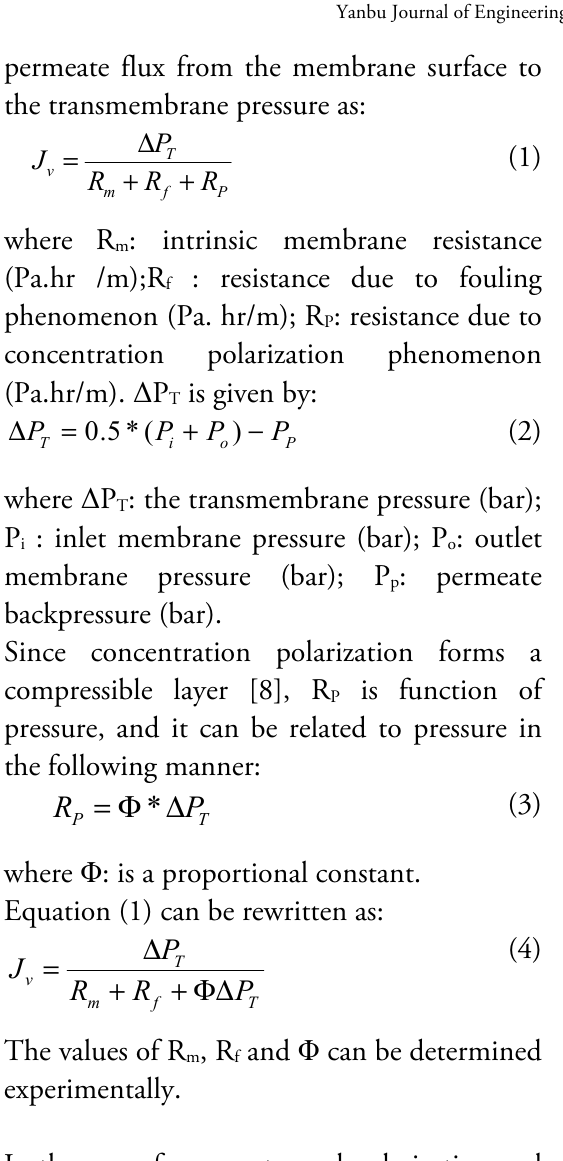
Fig.1. Chemical structure of (a) violet 5R, (b) C.I